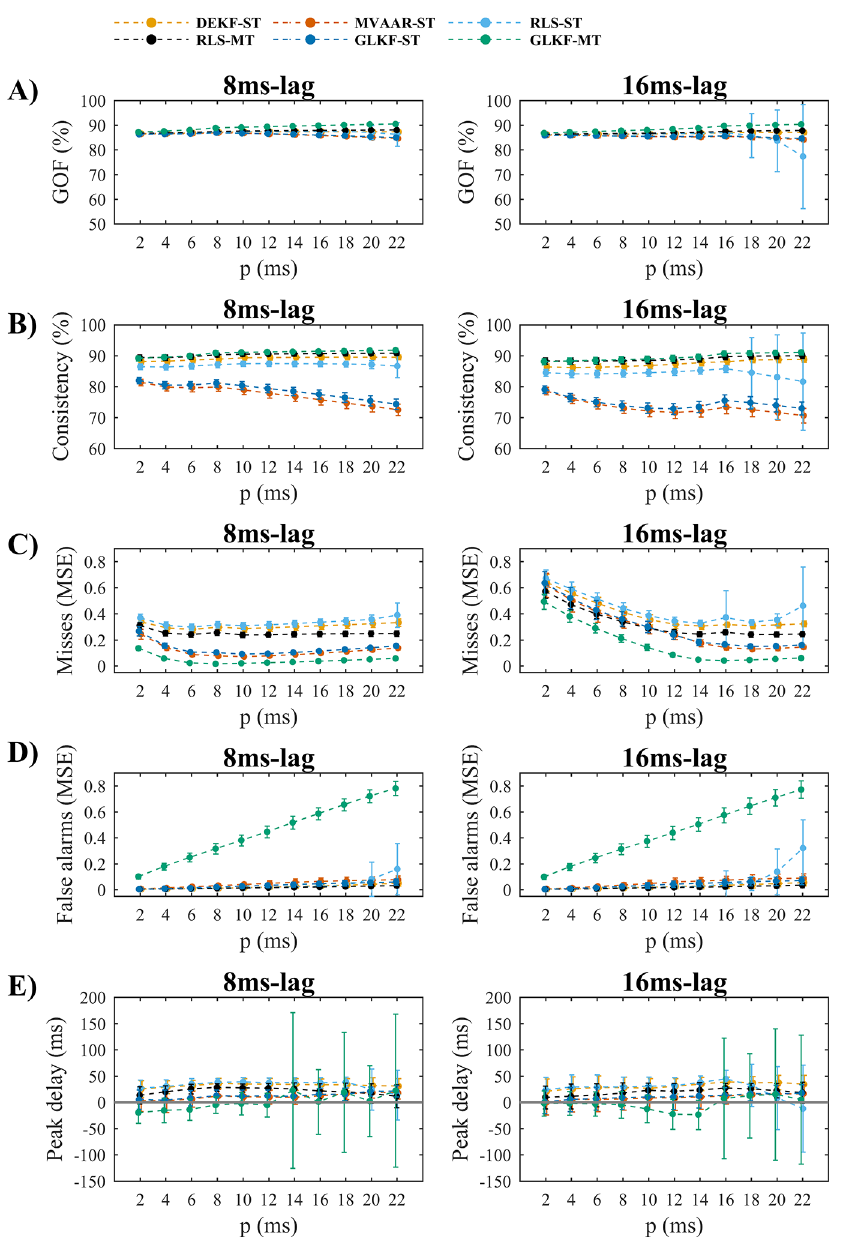
Fig 4. Simulation 2 on the effects of model order selection. A) Shows the goodness-of-fit (GOF). B) Shows the percent consistency. C) Shows the misses, which are computed as normalized mean squared differences between estimated and simulated values of the imposed causal influence from node 1 to node 2 (Fig 1C). D) Shows the false alarms, which are computed as normalized mean squared error on the null connection from node 2 to node 1 (Fig 1C). E) Shows the peak delay, which is computed as difference between peak latencies of estimated and simulated causal influence from node 1 to node 2 (Fig 1C). The results are shown for lags of the imposed causal influence of 8ms (left plots) and 16ms (right plots). In each plot the results are reported varying model order p , for the four recursive algorithms and the two ways of exploiting multiple trials: single-trial modeling and multi-trial modeling, available only for RLS and GLKF. Error bars represent 95% CI of the mean value computed across 50 simulations.